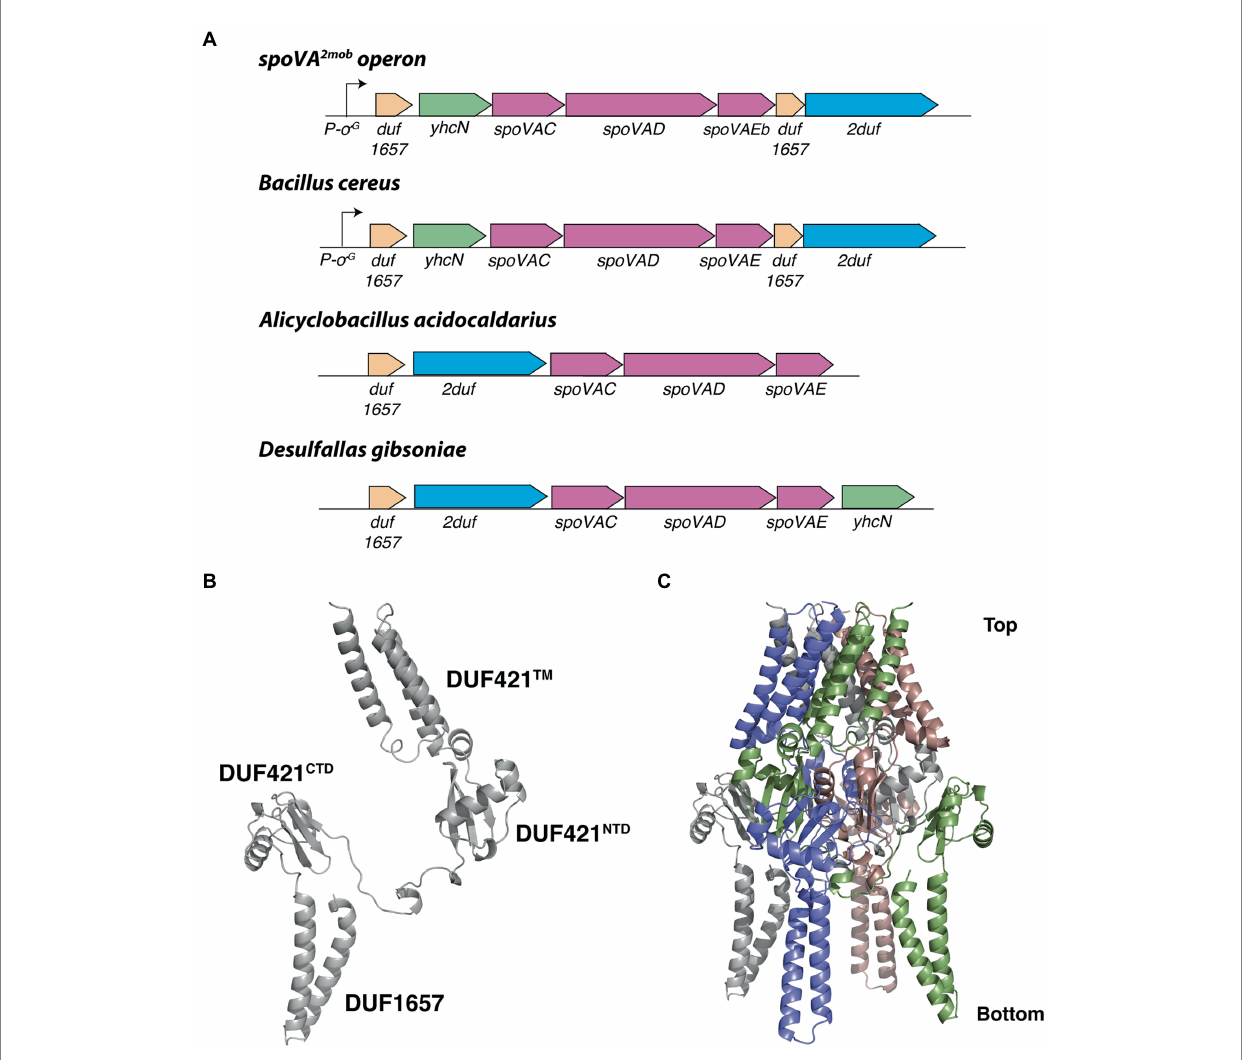
FIGURE 11 Local gene organization of representative 2 duf homologs and computed 2Duf structures. (A) Overview of the spoVA 2mob and representative 2duf homologs identified in Bacilli and Clostridia , shown in their genetic context. Both the spoVA 2mob and the 2duf homolog from B. cereus have a predicted σ G promoter binding site upstream of the first gene. (B) Computed 2Duf monomer structure by AlphaFold (Jumper et al., 2021) including the Duf421- like domain (TM, NTD, and CTD) and the Duf1657 domain, shown in an orientation similar to that in Figure 9D. (C) Tetrameric assembly of 2Duf, shown in an orientation similar to that in (B)